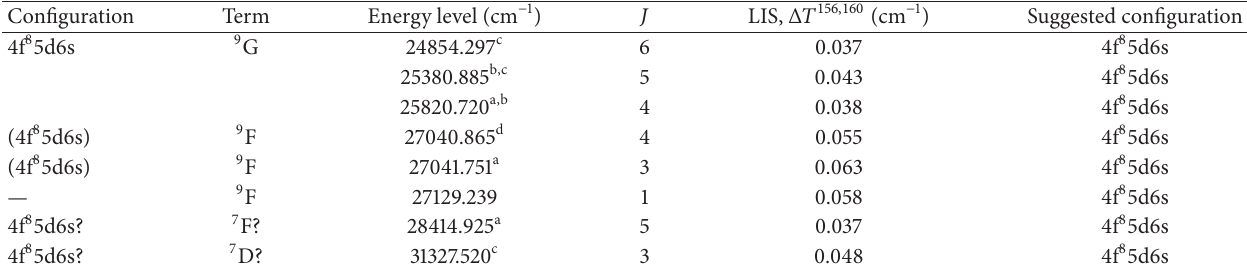
Table 5: Even-parity energy levels (cm −1 ) belonging to 4f 8 5d6s configuration are listed separately in Table 5. Configurations, terms, and 𝐽 values have been taken from [1]. LIS Δ𝑇 156,160 (cm −1 ) values have been referred from [6–9].